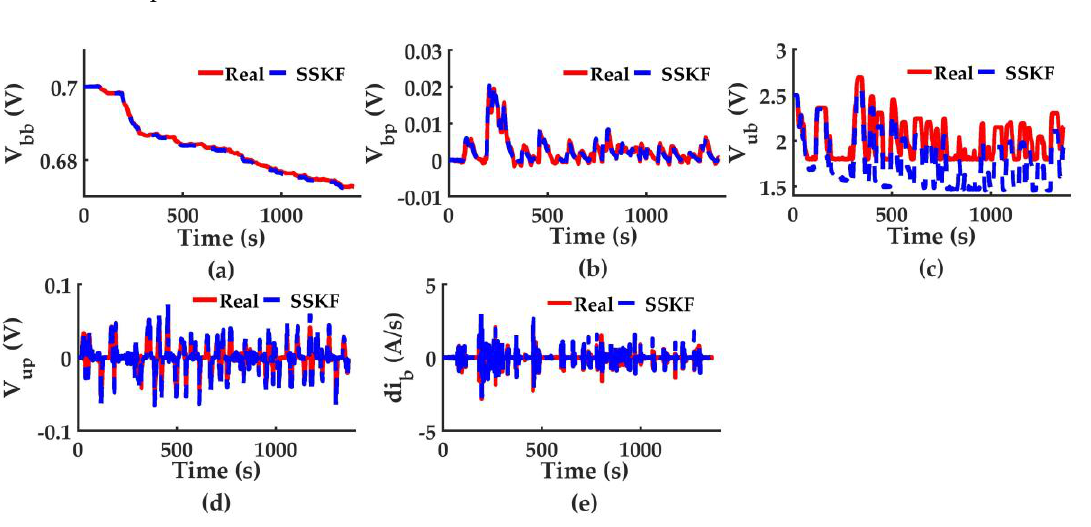
Figure 5. States values estimated by SSKF of SMPC. ( a ) V bb estimation; ( b ) V bp estimation; ( c ) V ub estimation; ( d ) V up estimation; ( e ) ∆ i b estimation.